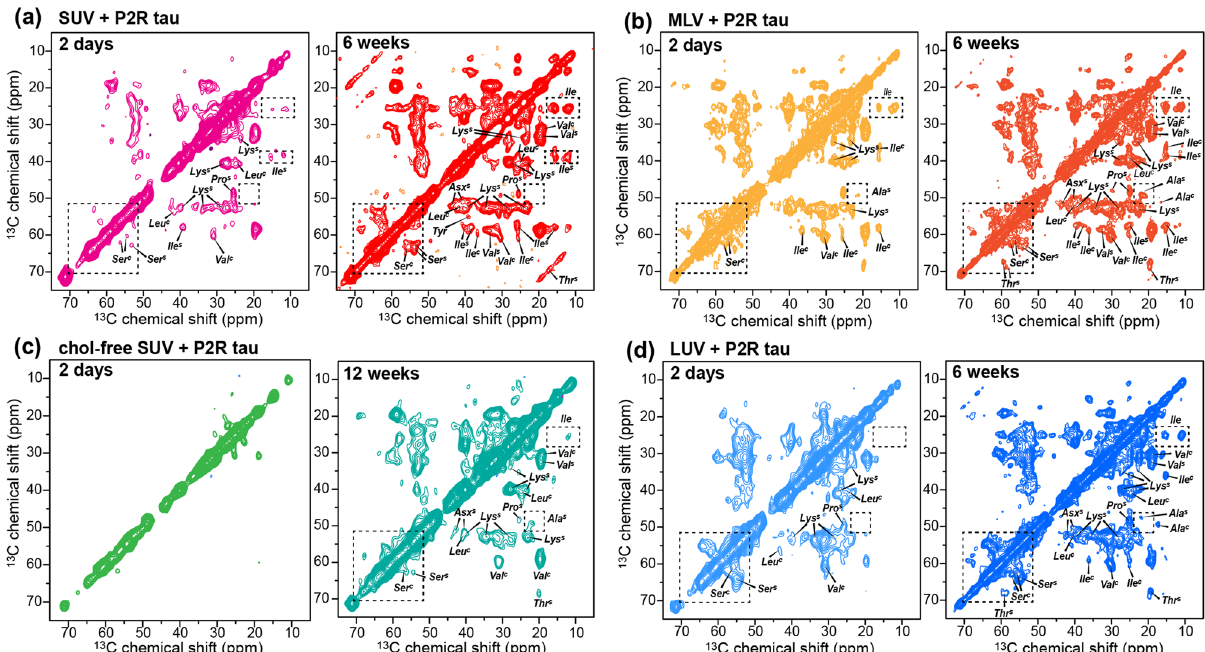
Fig. 3 2D 13 C- 13 C correlation spectra indicate slow conversion of membrane-bound tau from a disordered state to a β -sheet rich conformation. a 2D CC spectra of SUV-bound tau after 2 days and after 6 weeks, measured with CORD mixing times of 100 ms and 50 ms, respectively. β -sheet Ser, Val, Ile, and Lys intensities developed over time. A Tyr C α -C β cross peak at (55, 39) ppm is observed. b 2D CC spectra of MLV-bound tau measured with 50 ms mixing. β -sheet Ser, Ala, Ile and Lys intensities developed over time. c 2D CC spectra of Cholesterol-free SUV-bound tau measured with 100 ms CORD mixing. Almost no cross peaks were present initially. β -sheet signals grew over time but their intensities are weaker than the CHOLESTEROL-containing membrane samples. d 2D CC spectra of LUV-bound tau measured with 50 ms mixing. Both random-coil and β -sheet signals of Ser, Ala, and Lys developed over